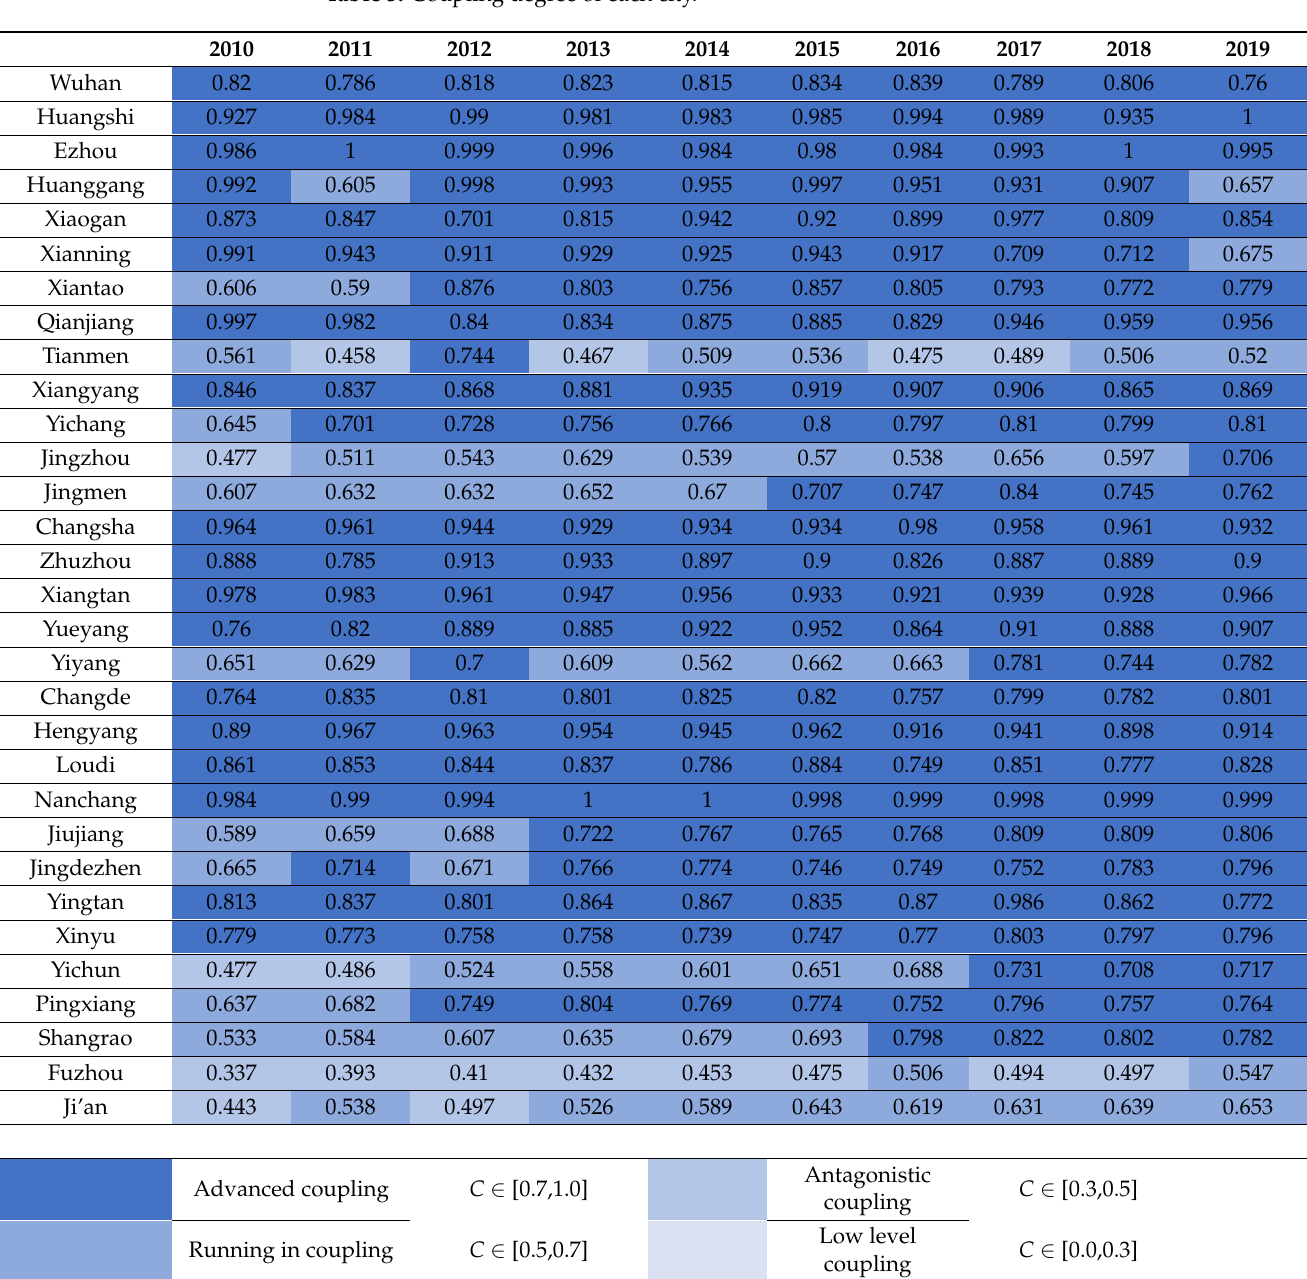
Table 3. Coupling degree of each